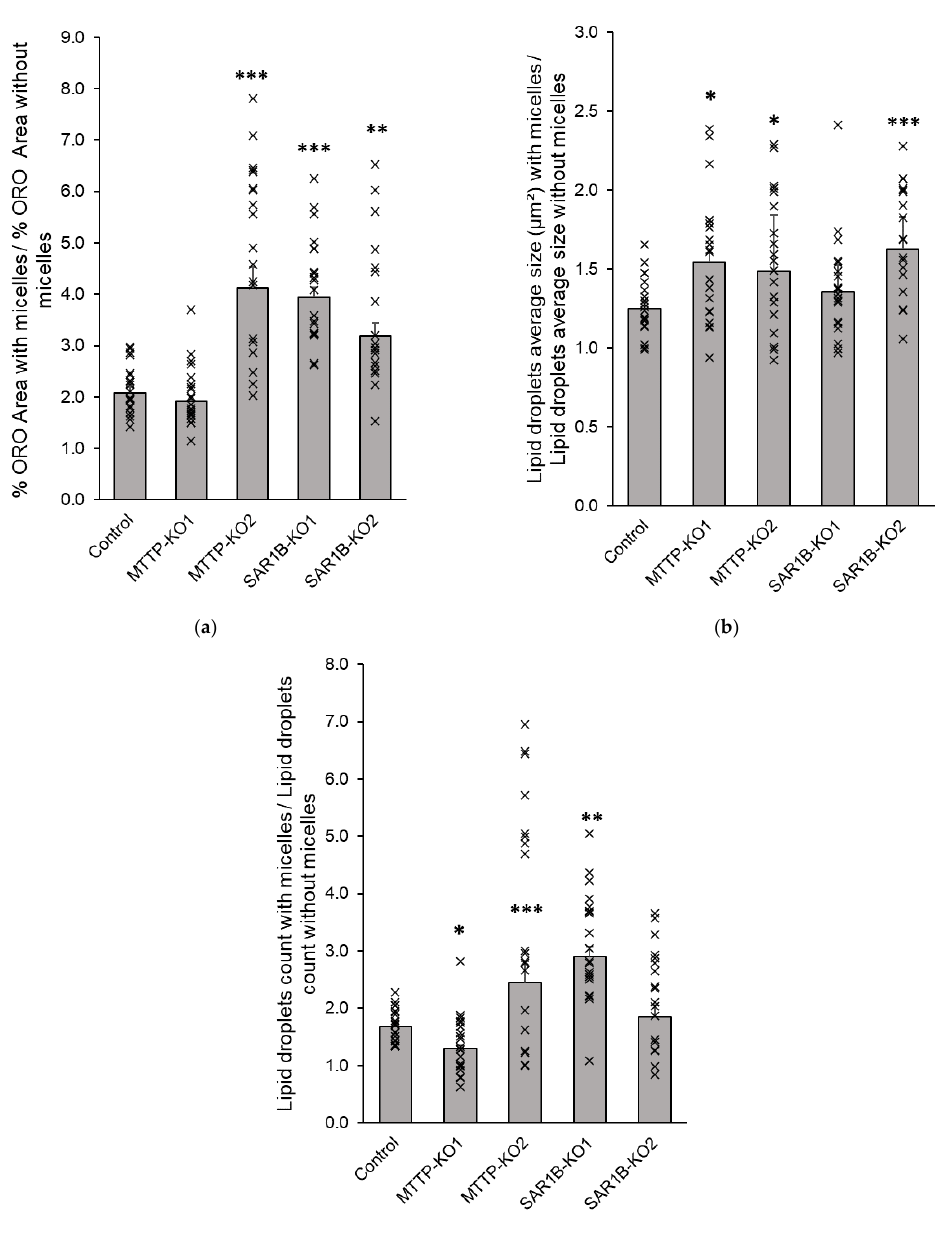
Figure 7. Lipid accumulation in KO clones and control cells. Cells were cultured on inserts for 21 days. Quantification of lipid accumulation was assessed by the ratio of increases in ( a ) red surface area (Oil red O staining), ( b ) lipid droplets count per field and ( c ) lipid droplets size between cells incubated without micelles and cells incubated with micelles for 16 h. Data are expressed as means ( n = 20). Asterisks indicate a statistically significant difference between control and KO clones (* p < 0.05, ** p < 0.001, *** p <